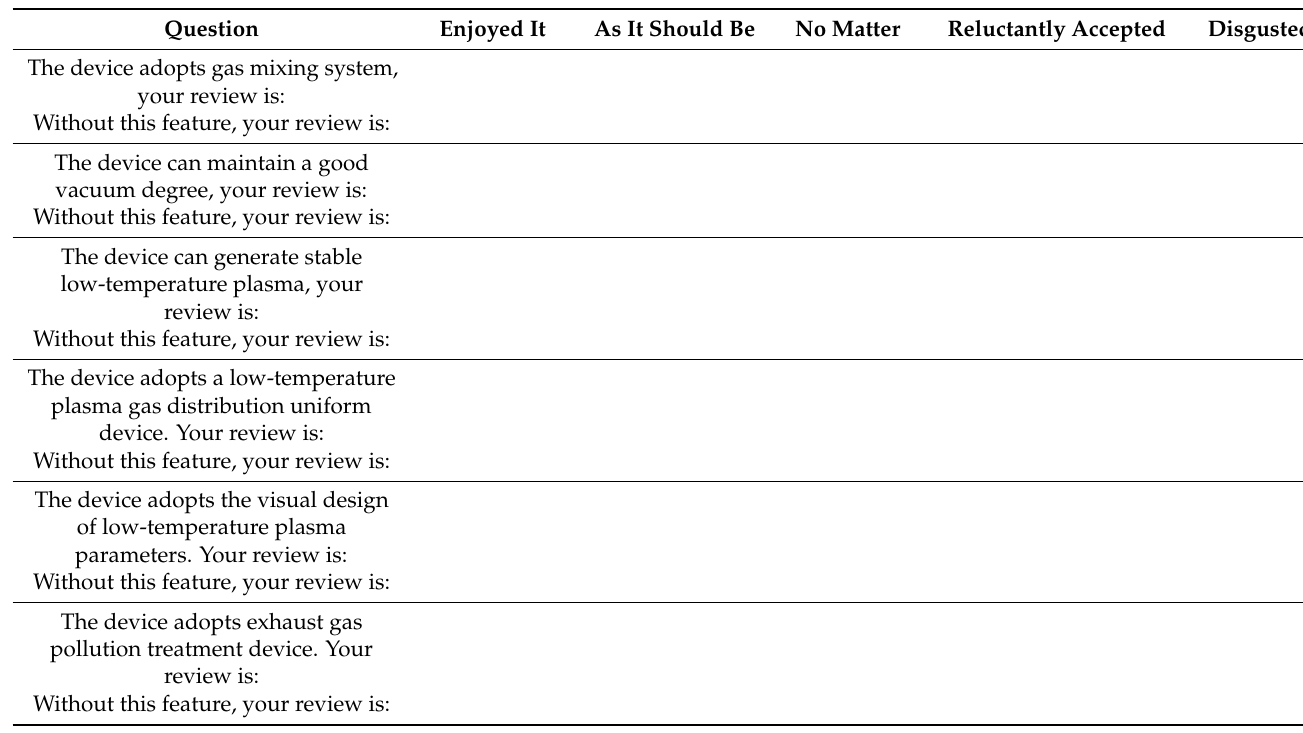
Table A1. The satisfaction questionnaire for low-temperature plasma deposition device.